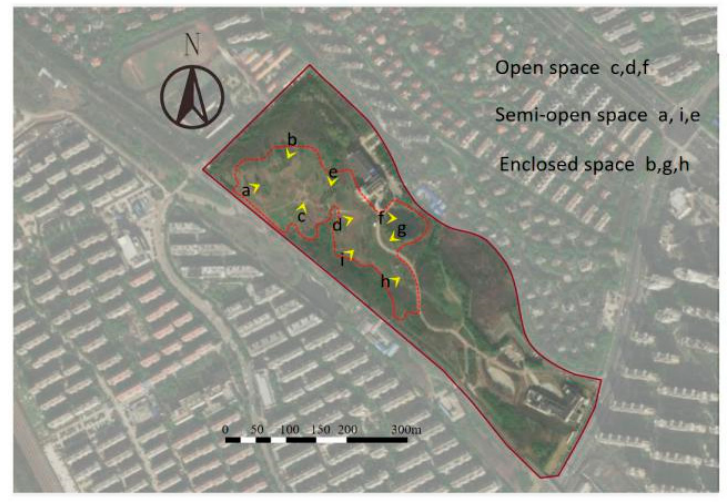
Figure 4. Spatial type distribution map.